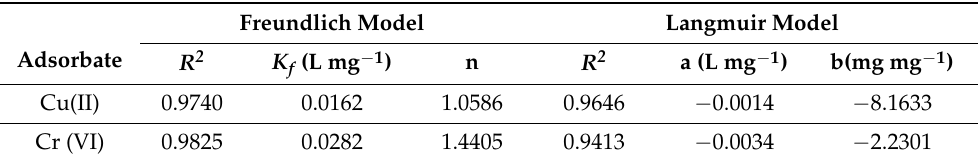
Figure 10. Isotherm modeling for the removal of Cu(II) and Cr(VI) from aqueous solution using M-OPEFB-CNF as a bio-sorbent. ( a ) Freundlich isotherm model, and ( b ) Langmuir isotherm model. Table 1. Freundlich and Langmuir model for the removal of Cu(II) and Cr(VI) from aqueous solution using M-OPEFB-CNF as a